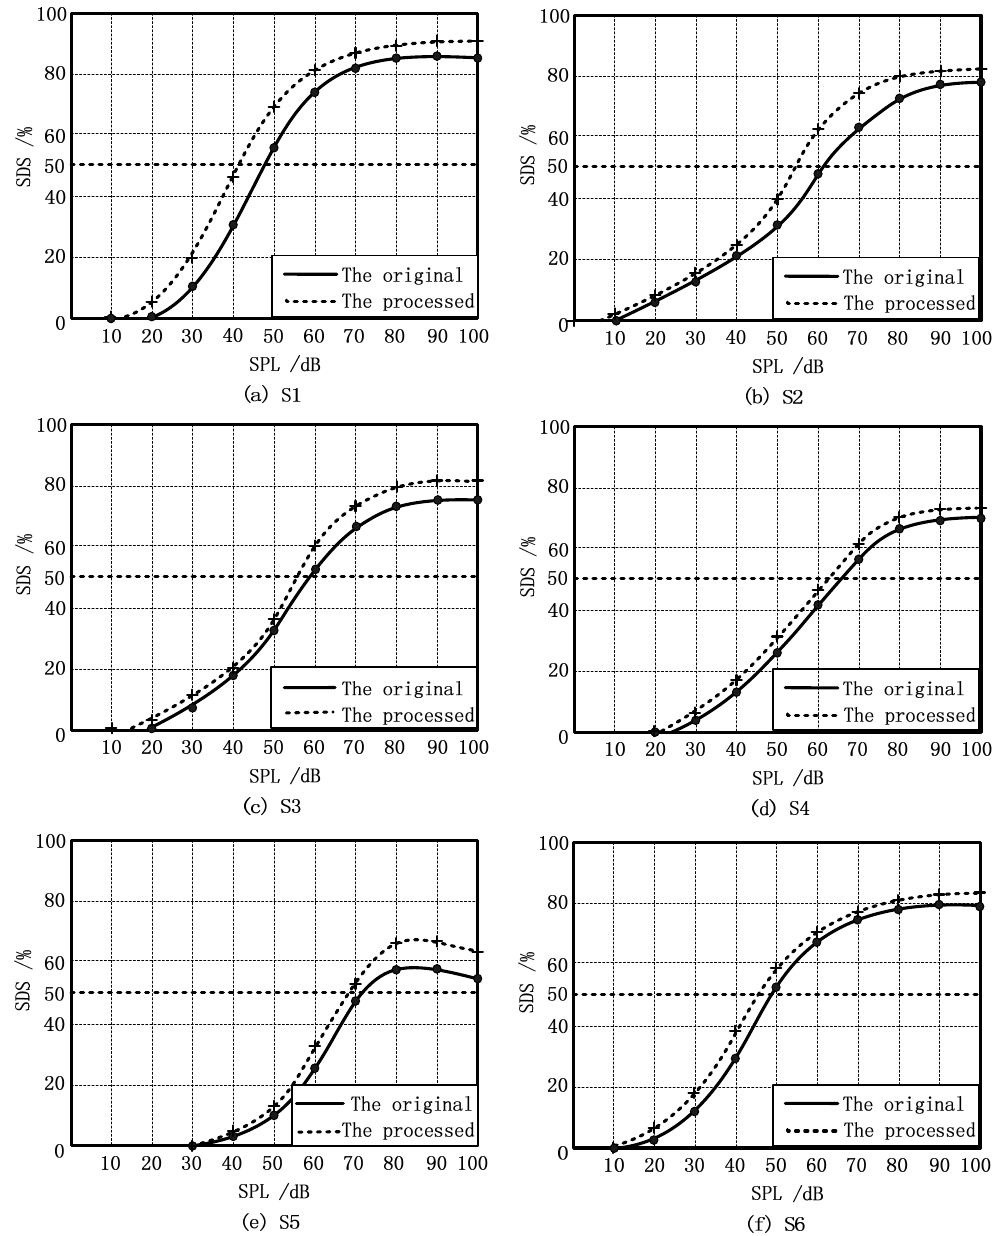
Figure 6. Performance ‐ intensity (P ‐ I) curves using the original and the processed vocabularies with six subjects: ( a ) S1; ( b ) S2; ( c ) S3; ( d ) S4; ( e ) S5; ( f ) S6.